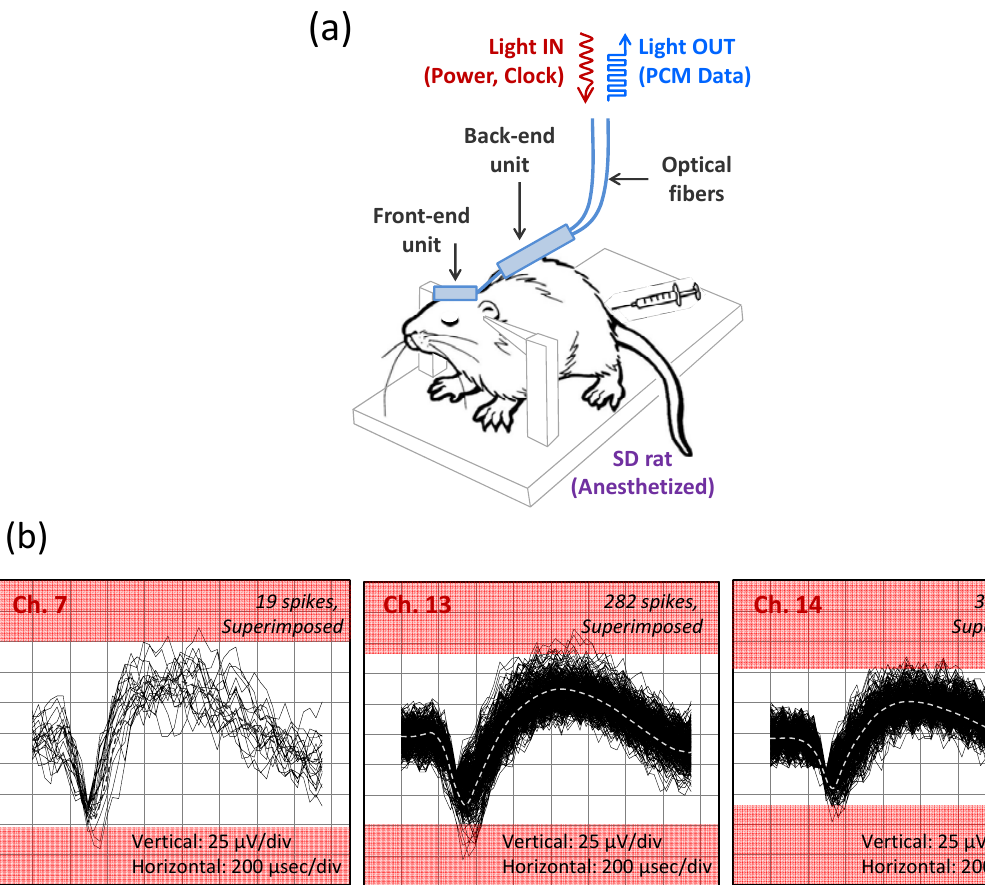
Figure 8. In vivo recording of neural activity from the somatosensory cortex of a rat made by the fully integrated 16 channel neural sensing microsystem equipped with fiber-optic data transmission and power delivery components. ( a ) Schematic illustration of in vivo recording setup with anesthetized rat; ( b ) An example of the neural signals showing three active channels simultaneously recorded with the microsystem, where the spikes (single unit activities) are superimposed with an average value shown by a dotted line as a guide to the